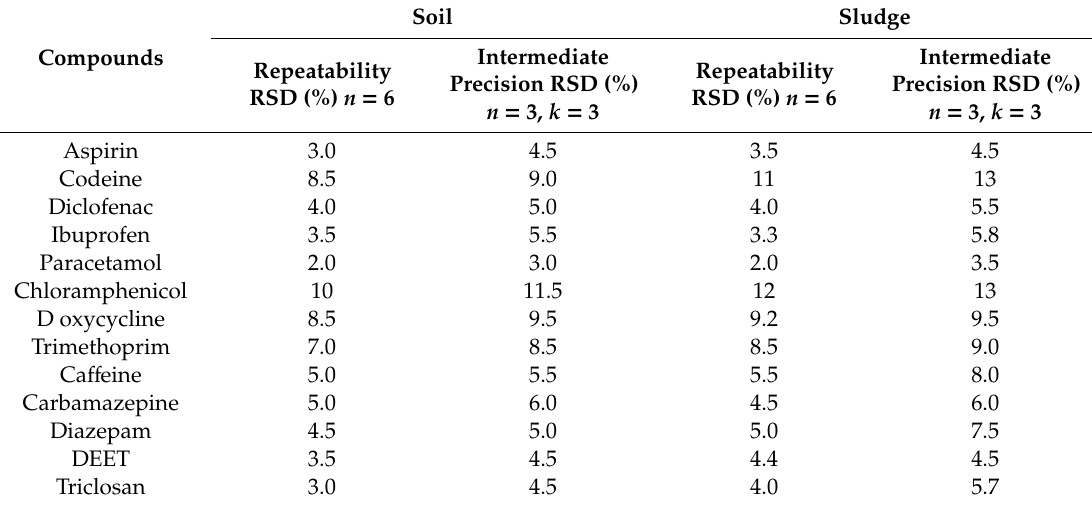
Table 3. Precision data of the extraction procedures for the two types of substrates.